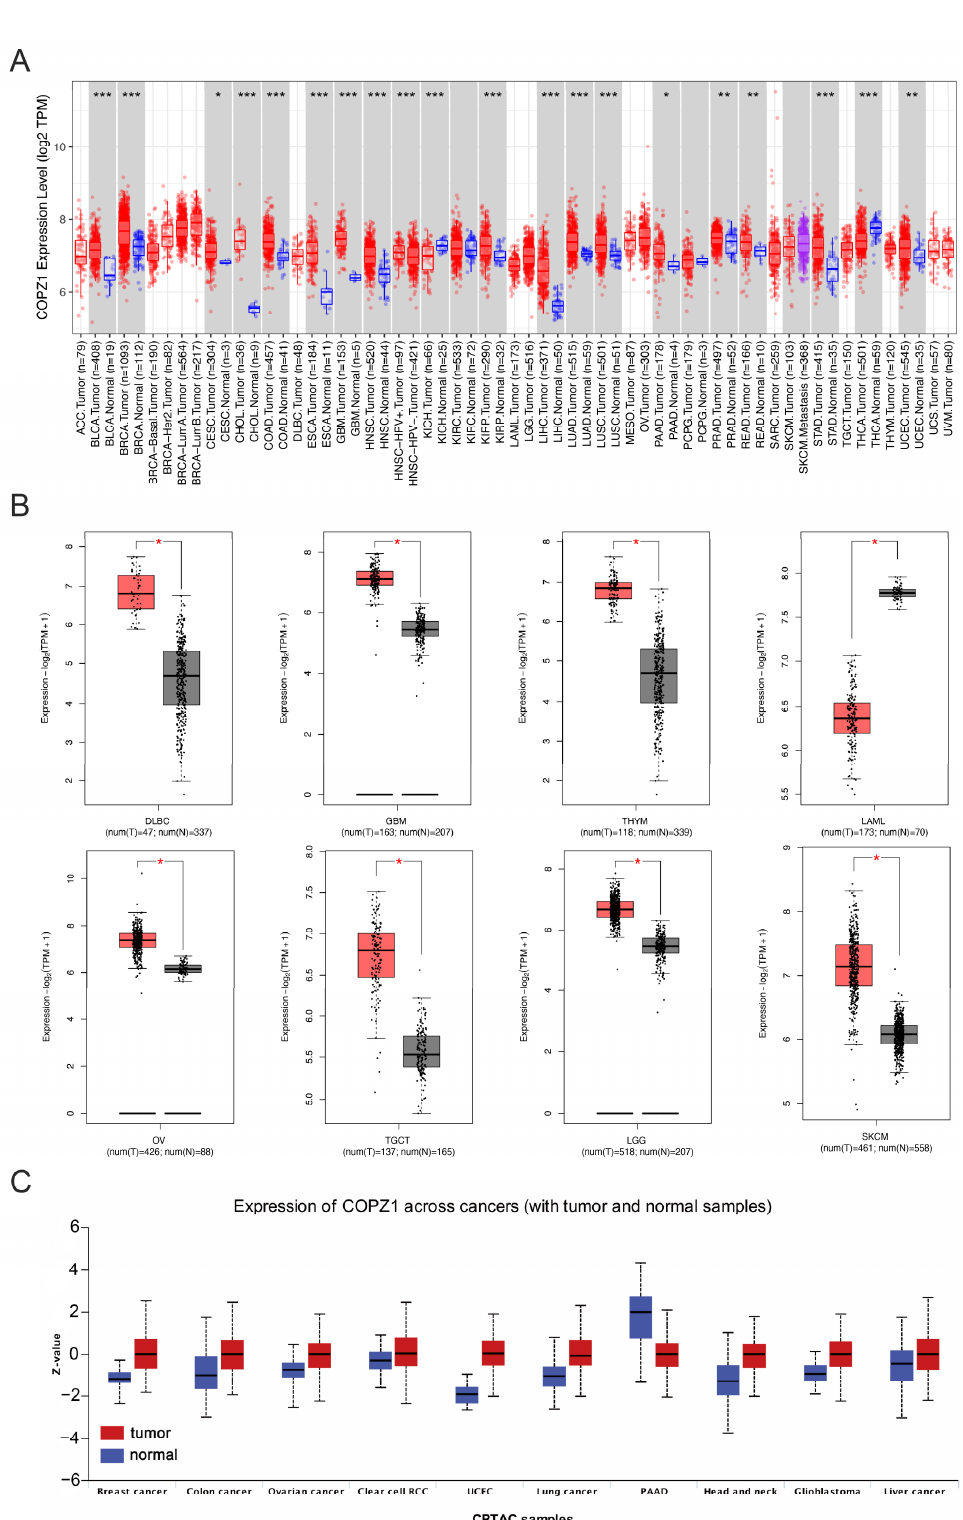
HNSC and liver cancer. (Figure 1C). In pancreatic cancer, the albumin level of COPZ1 was lower in tumor tissue when compared to normal tissue.